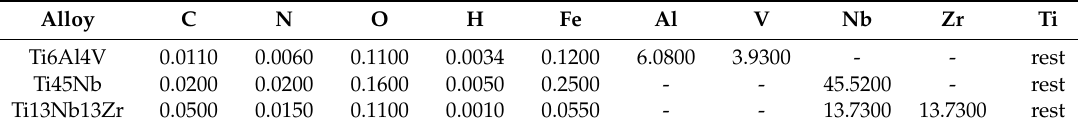
Table 1. Composition in % weight of the alloys tested.